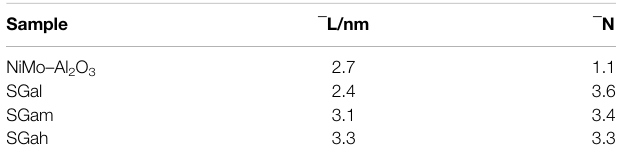
TABLE 2 | Average length and layer stacks of impregnated Ga-modi fi ed Ni – Mo/ Al 2 O 3